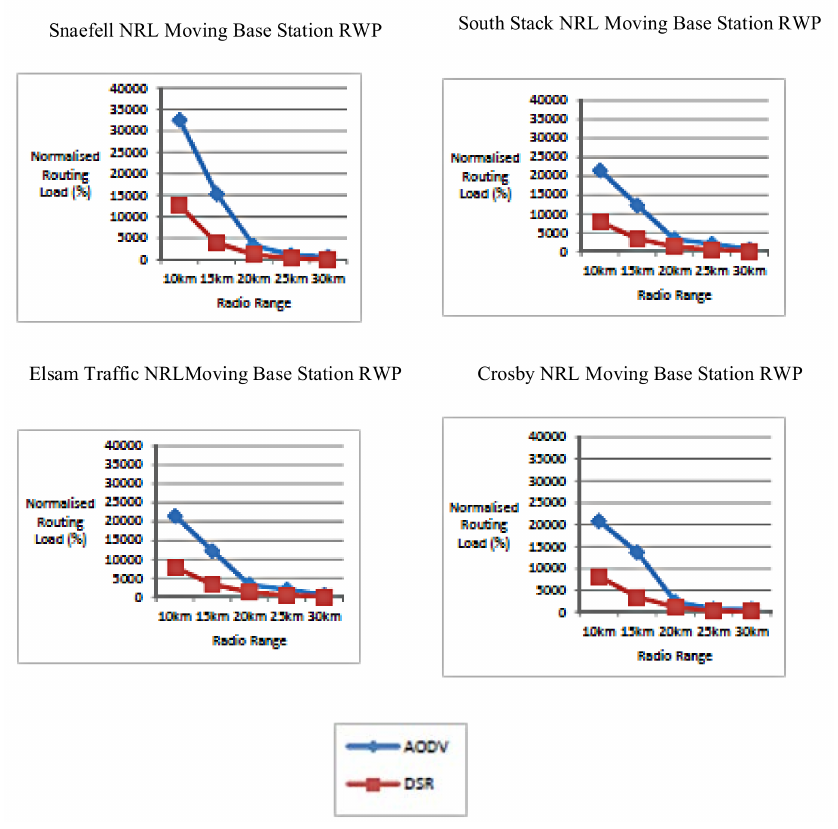
Figure 16. Moving Base Station Random Waypoint Shipping Model with Normalized Routing